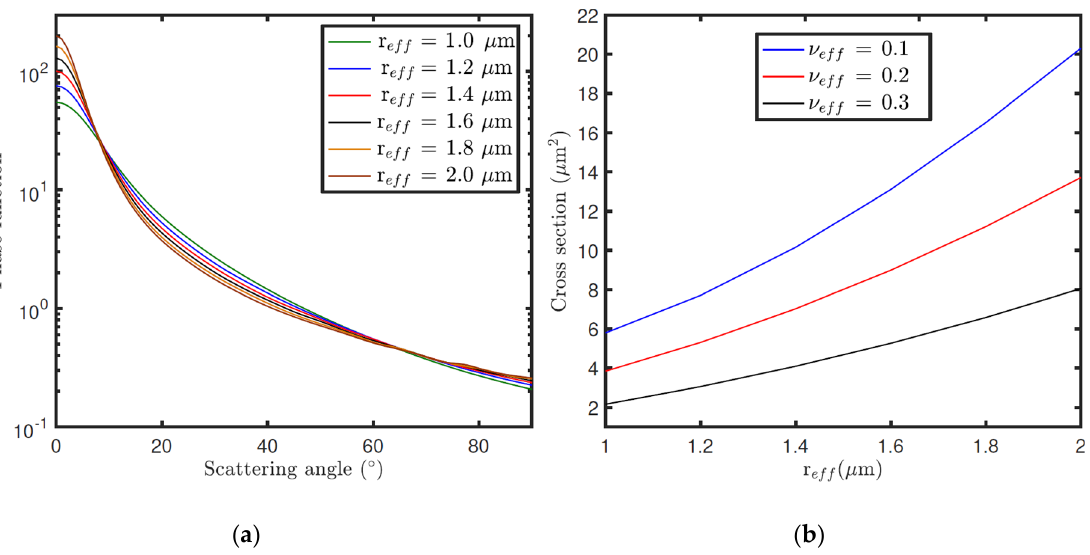
Figure 19. ( a ) Phase functions of equal cylindrical particles computed at 0.75 µm for a set of r eff values and a constant v eff = 0.3. ( b ) Variation of the equal-cylindrical-particle extension cross-section with r eff at 0.75 µm for a set of v eff values.